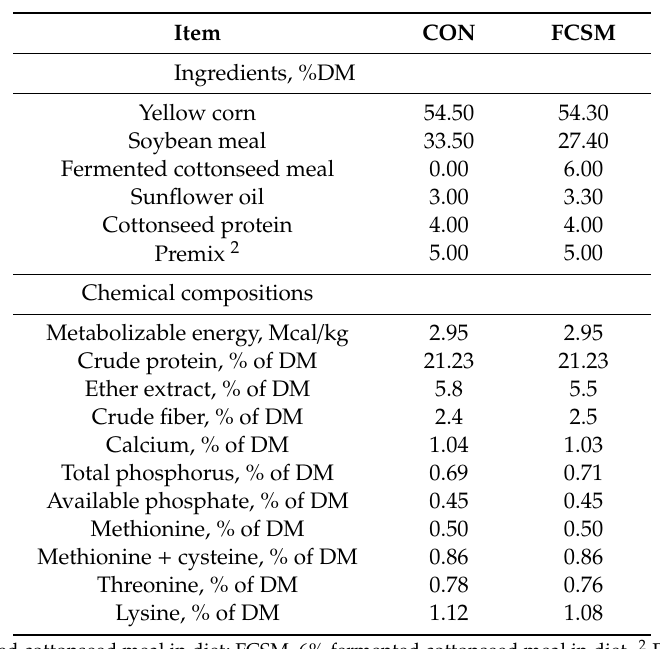
Table 1. Diet compositions and nutrient contents of the experimental diets 1 .